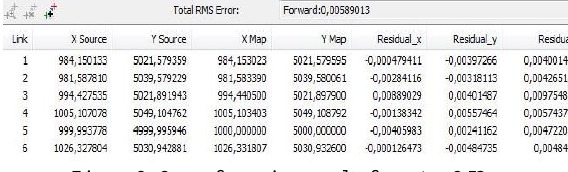
Figure 8: Georeferencing results from ArcGIS.